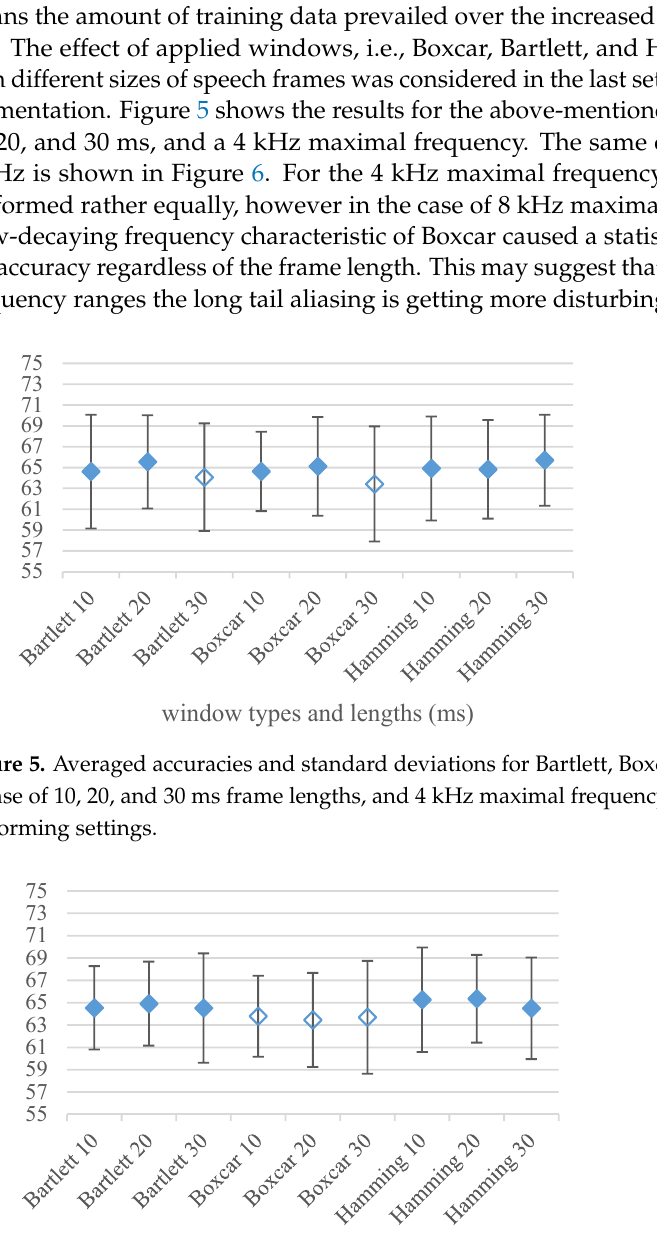
Figure 4. Averaged accuracies and standard deviations for 0.5, 0.8, 1, and 1.2 s block lengths (bl) with 0.1, 0.2, and 0.4 s shifts (sh) between adjacent blocks and an 8 kHz maximal frequency. Filled marks show equally performing settings.